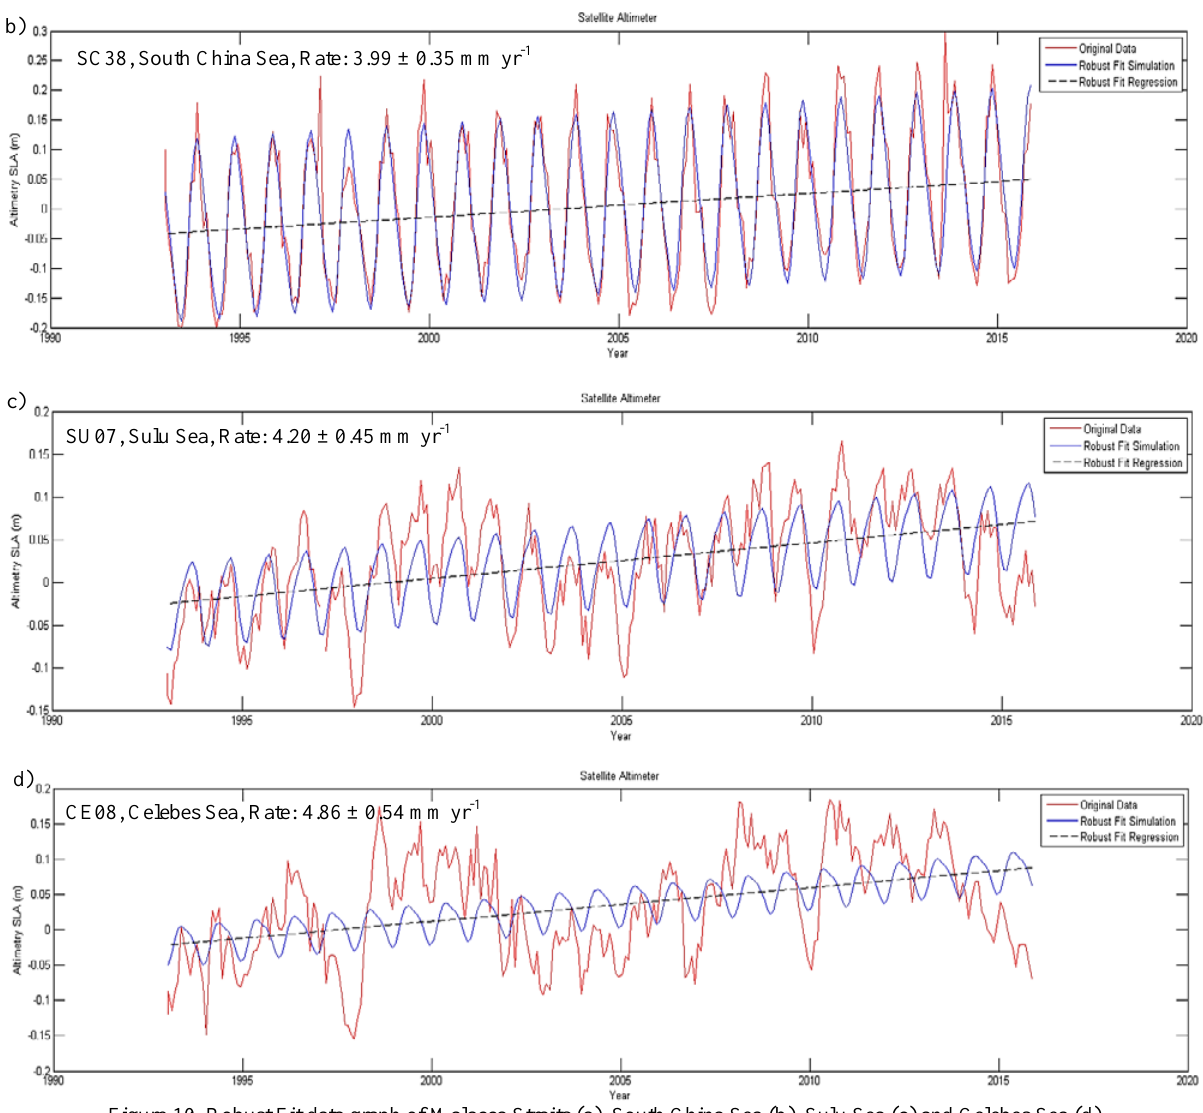
Figure 10. Robust Fit data graph of Malacca Straits (a), South China Sea (b), Sulu Sea (c) and Celebes Sea (d)